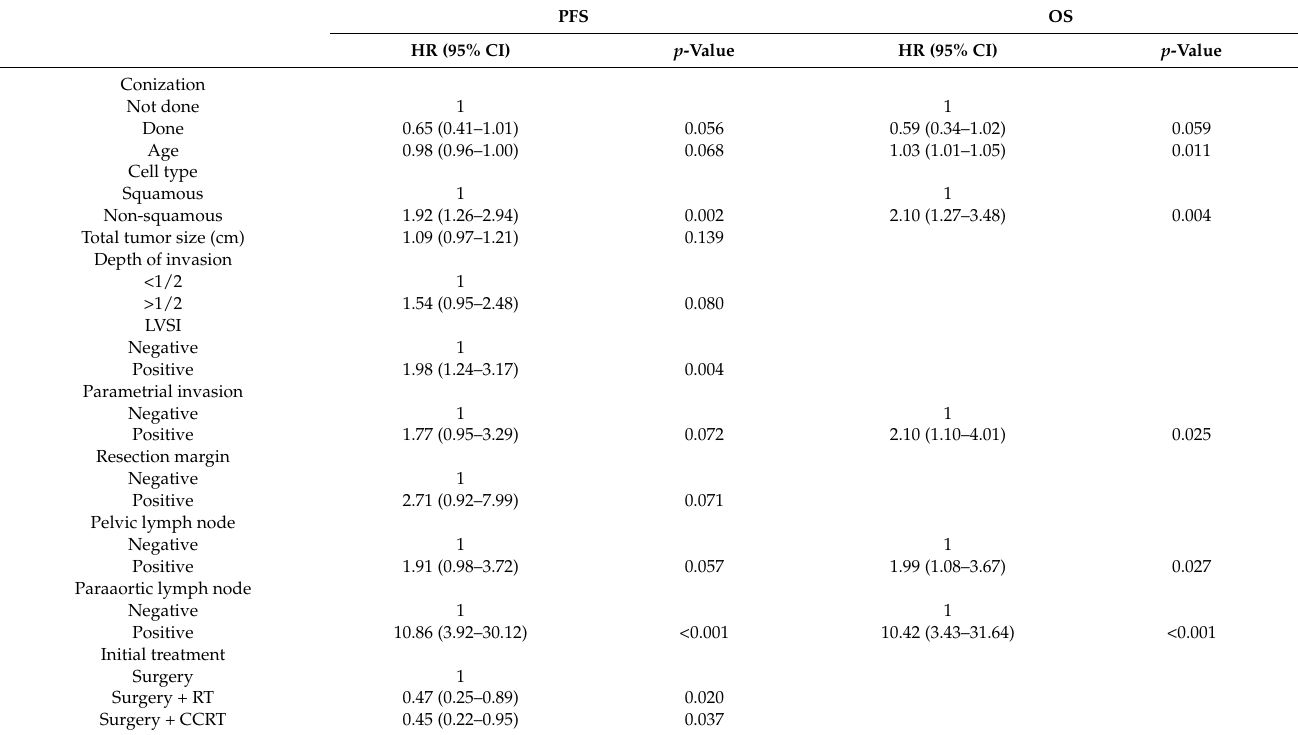
Table 2. Multivariate analysis for progression ‐ free survival and overall survival.